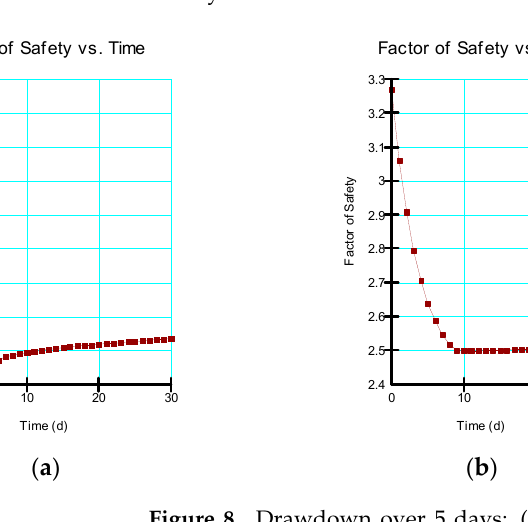
Figure 8. Drawdown over 5 days: ( a ) normal operating reservoir level, ( b ) reduced operating reservoir level, ( c ) overflow operating reservoir level.